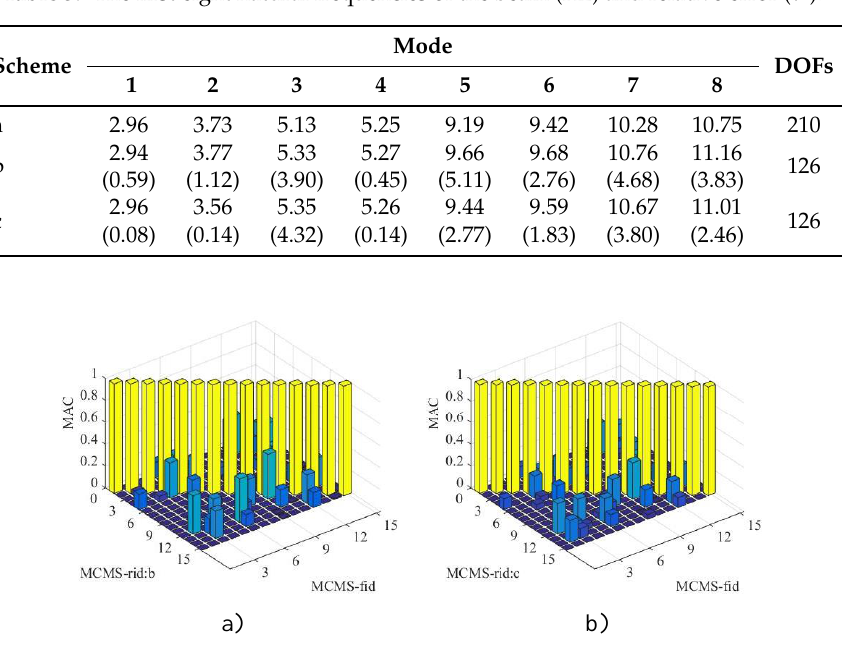
Figure 10. Modal assurance criterion between the modes by the MCMS-fid method and MCMS-rid method different interpolation schemes. ( a ) MCMS-rid:b vs. MCMS-fid; ( b ) MCMS-rid:c vs. MCMS-fid.